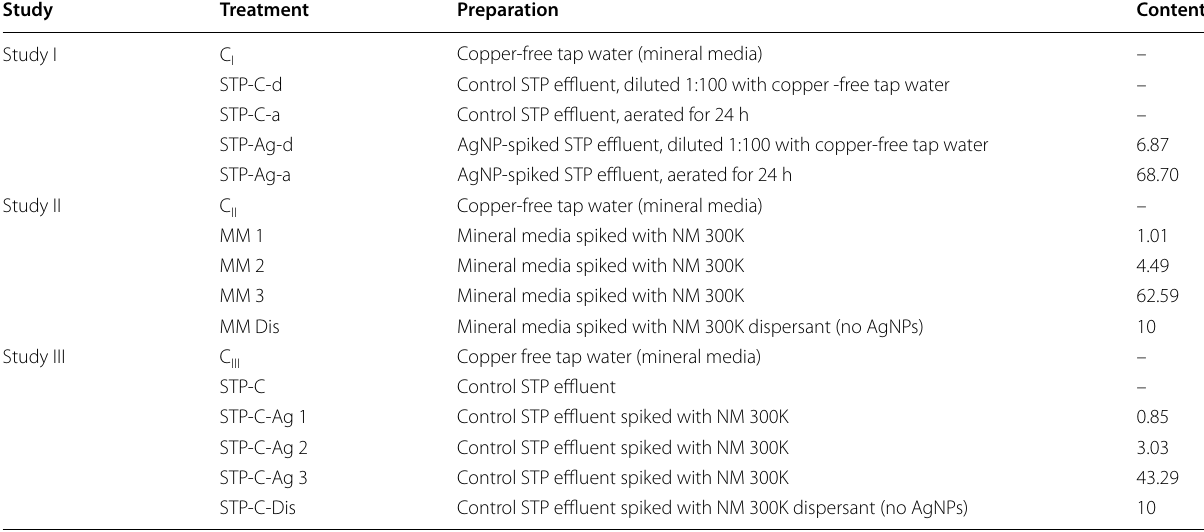
Total Ag and dispersant concentration in